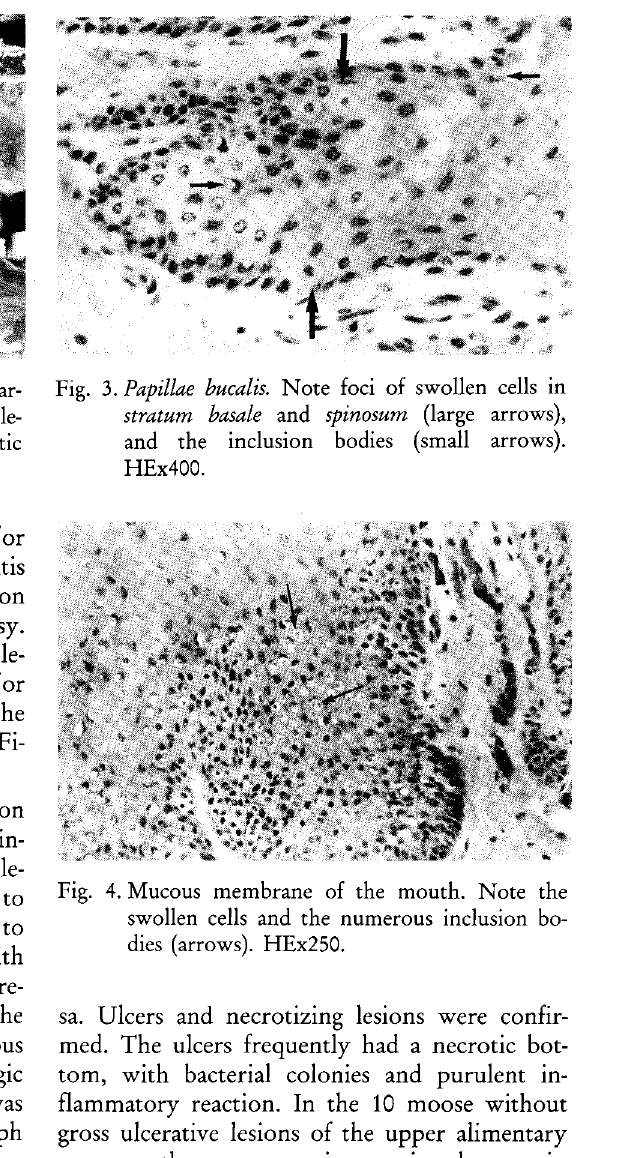
Fig. 4. Mucous membrane of the mouth. Note the swollen cells and the numerous inclusion bo dies (arrows).